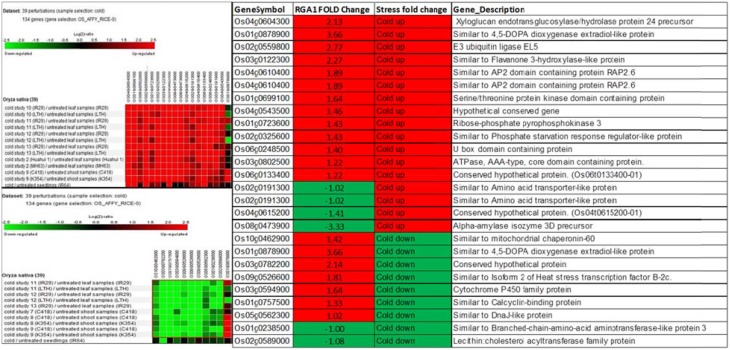
Expression profiles of 106 RGA1-regulated stress-responsive genes in cold stress (39 perturbations from literature). The red and green colors indicate up-regulation (log2 [2.5]) and down-regulation (log2 [−2.5]), respectively, as shown in the color bar. The expression data in the left panel were obtained using Genevestigator. The table compares their regulation in normal plants under stress in literature with actual fold-change values in the RGA1 mutant.